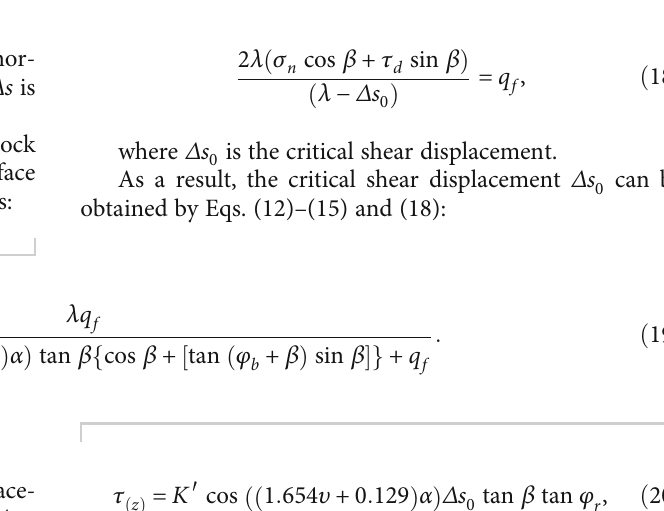
Figure 6: Veri fi cation in case of slope angle α = 0 ° : (a) comparison in depth with 53 MN vertical load; (b) comparison in depth with 32 MN vertical